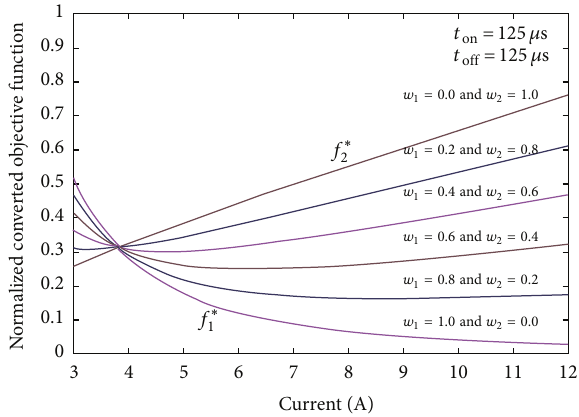
Figure 7: Shape change of normalized converted objective function for different weight factor